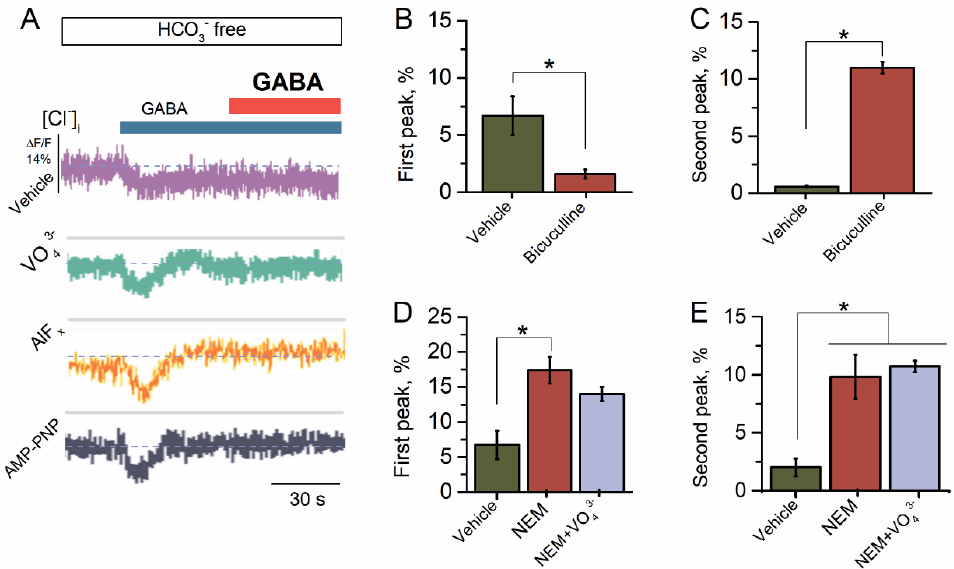
Figure 1. Reapplication of GABA causes a desensitization of GABA A R-mediated Cl − influx. ( A ) Representative images of MQAE fluorescence changes in SNs recorded in response to the first application of GABA (100 µ M) and reapplication of GABA (100 µ M) in the HCO 3 − -free experimen- tal medium, without or in the presence of VO 43 − (20 µ M), AlF x (20 µ M), or AMP-PNP (2 mM). ( B ) Bar graph of percentage in MQAE peak fluorescence changes in response to the first application of GABA (100 µ M), without or in the presence of bicuculline (50 µ M) in an experimental medium (one-way ANOVA, Tukey’s test: F (19) = 6.7, p = 0.005, n = 5). ( C ) Bar graph of percentage in MQAE peak fluorescence changes in response to reapplication of GABA (100 µ M), without or in the presence of bicuculline (50 µ M) in an experimental medium (one-way ANOVA, Tukey’s test: F (19) = 142.7, p = 0.0000025, n = 5). ( D ) Bar graph of percentage in MQAE peak fluorescence changes in response to first application of GABA (100 µ M) without or containing NEM (300 µ M) in an experimental medium, in the absence or presence of VO 4 3 − (20 µ M) (one-way ANOVA, Tukey’s test: F (19) = 16.4, p = 0.005 or F (19) = 23.8, p = 0.005, n = 5), respectively. ( E ) Bar graph of percentage in MQAE peak fluorescence changes in response to reapplication of GABA (100 µ M) without or containing NEM (300 µ M), in the absence and presence of VO 43 − in an experimental medium (20 µ M) (one-way ANOVA, Tukey’s test: F (19) = 9.1, p = 0.05 or F (19) = 106.2, p = 0.00005, n = 5). All data in the bar graphs in this figure and those proceeding it are presented as mean values +/ − SEM; * p <